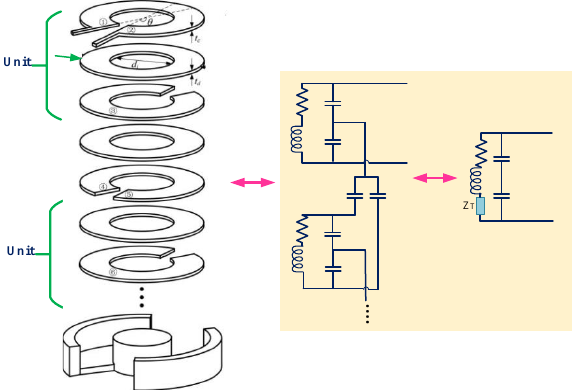
Figure 4. A WPT structure to enhance the Q-factor of the system.